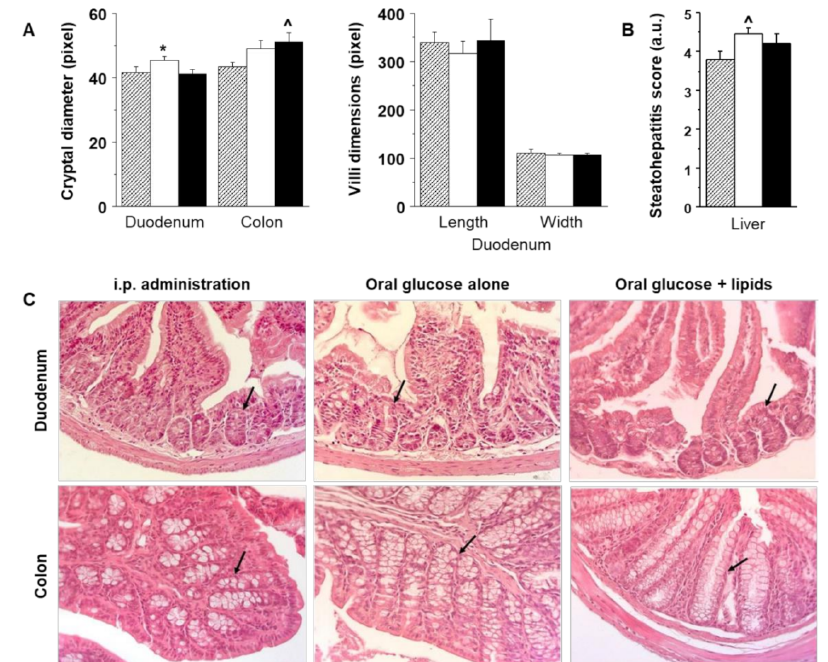
Figure 5. Intestinal villi and crypts, and steatohepatitis score: Histology parameters ( A ), showing greater duodenal crypt dimensions after oral glucose (white bar) than glucose + lipid (black bar), and a progressive enlargement in colon crypts in the oral glucose and glucose + lipid protocols compared to the i.p. group (hatched bar), and corresponding steatohepatitis scores ( B ), showing higher values in the oral glucose protocol compared to the i.p. group. Panel ( C ) provides representative examples of histological sections in the three study groups, in which arrows were positioned to indicate crypts.